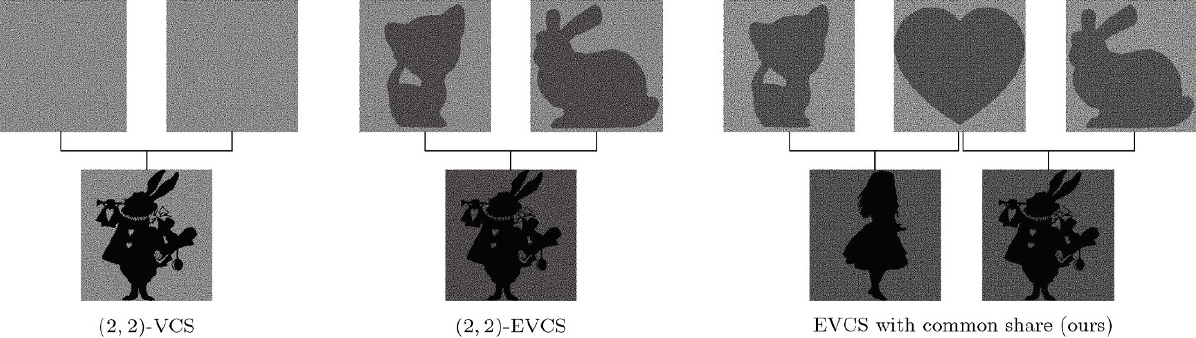
Fig. 1 Left: example of basic (2 , 2)-VCS. Middle: example of (2 , 2)-EVCS. Right: proposed EVCS with common shares. The share images (top row) are stacked (physically superimposed) to decrypt the secret images (bottom row). The proposed method can decrypt multiple images using a common share. Input images are 200 × 200 pixels and output images are 400 × 400